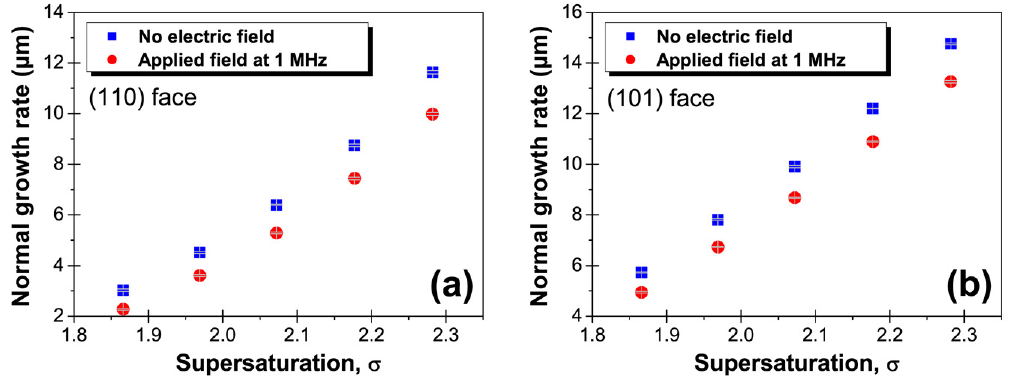
Figure 3. Supersaturation dependence of growth rate for ( a ) (110) and ( b ) (101) faces of tetragonal hen egg white (HEW) lysozyme crystals grown with and without an external electric